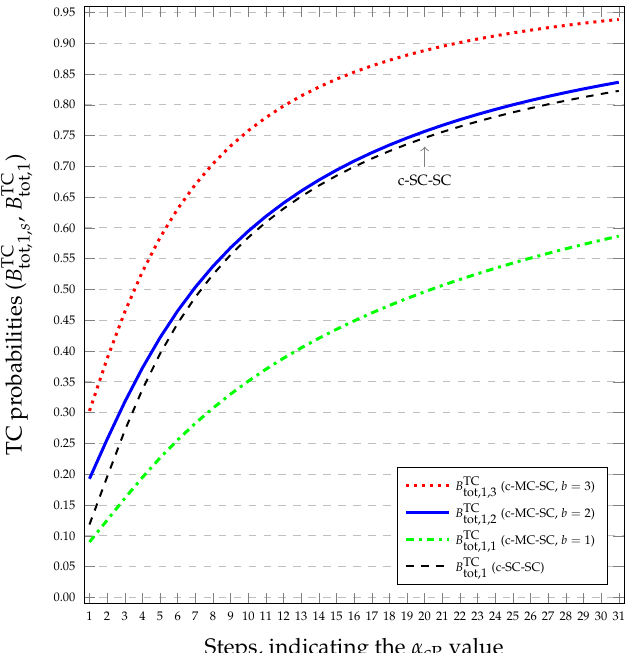
Figure 7. Total TC probabilities, B TC